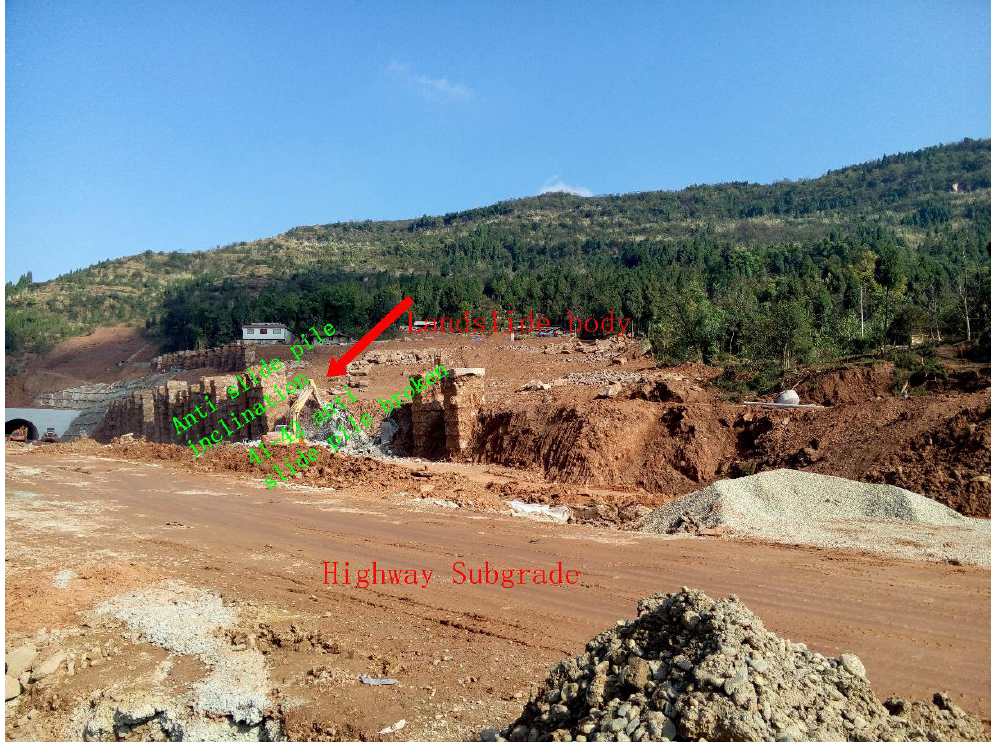
Figure 3. Fracture and inclination of the anti-slide pile.